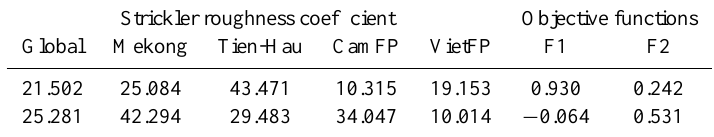
Table 5. Parameter sets and objective function values for best solutions for F1 (first line) and F2 (second line).